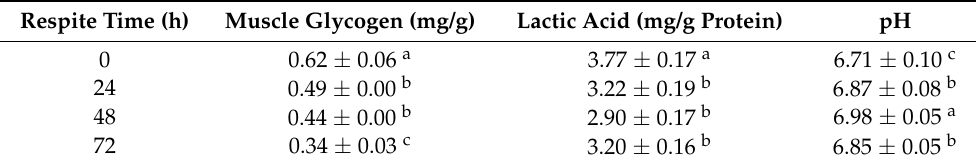
Table 1. The effect of respite time before live transportation on muscle glycogen, lactic acid, and pH of blunt snout bream (n = 3 for each respite time). Respite Time